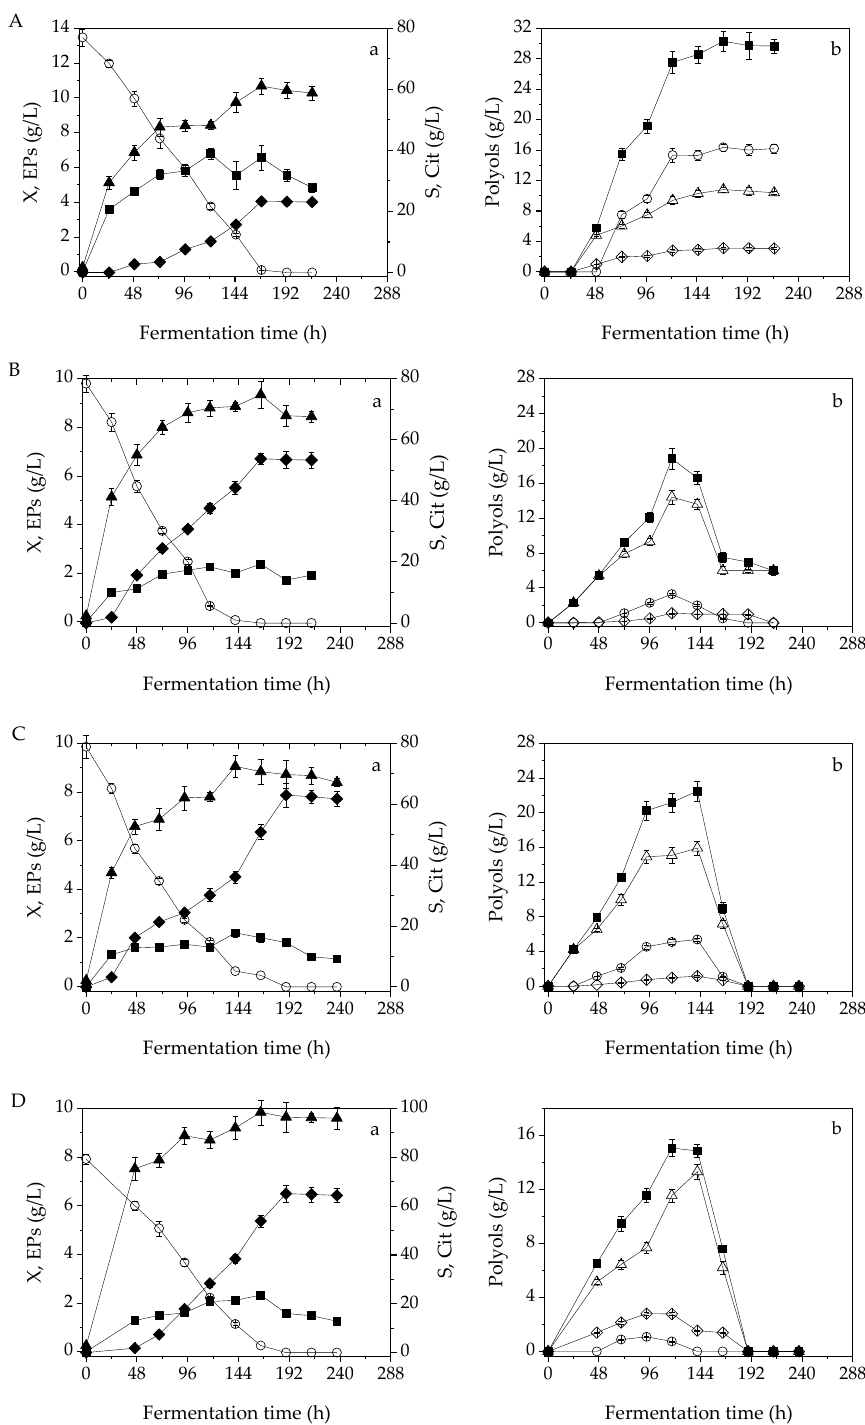
Figure 2. Kinetics of (a) biomass (X, g/L, ▲ ) and endopolysaccharides (EPs, g/L, ■ ) and citric acid (Cit, g/L, ◆ ) production, as well as glycerol (S, g/L, ○ ) consumption and (b) total polyols (g/L, ◼ ), mannitol (g/L, △ ), arabitol (g/L, ◇ ), erythritol (g/L, ○ ) production during shake-flask fermentations of Y. lipolytica ACA-YC 5033 when 0 g/L ( A ), 1 g/L ( B ), 2 g/L ( C ), 3 g/L ( D ) g/L of phenolic compounds were applied in shake-flask nitrogen-limited media. The culture conditions were: 250 mL Erlenmeyer flasks filled up to 50 mL at 180 rpm, initial pH = 6.0, pH ranging between 4.8 and 6.0, incubation temperature T = 28 °C, initial glycerol concentration of 77.9 ± 0.52 g/L. Table 3 depicts the evaluation of color removal that was attained by both yeast strains on blends of OMW-crude glycerol. In all fermentations, maximum decolorization values were achieved at a more prolonged fermentation time by LMBF Y-46, compared to ACA- YC 5033. In the case of LMBF Y-46, its ability to decolorize OMW-glycerol blends was significantly reduced ( p < 0 . 05) with increasing Phen concentration while the maximum value of 31.1% (after 121 h) was observed at Phen = 1 g/L. In the case of ACA-YC 5033, the highest color removal of 25.9% was monitored at Phen = 3 g/L after 96 h of fermentation.